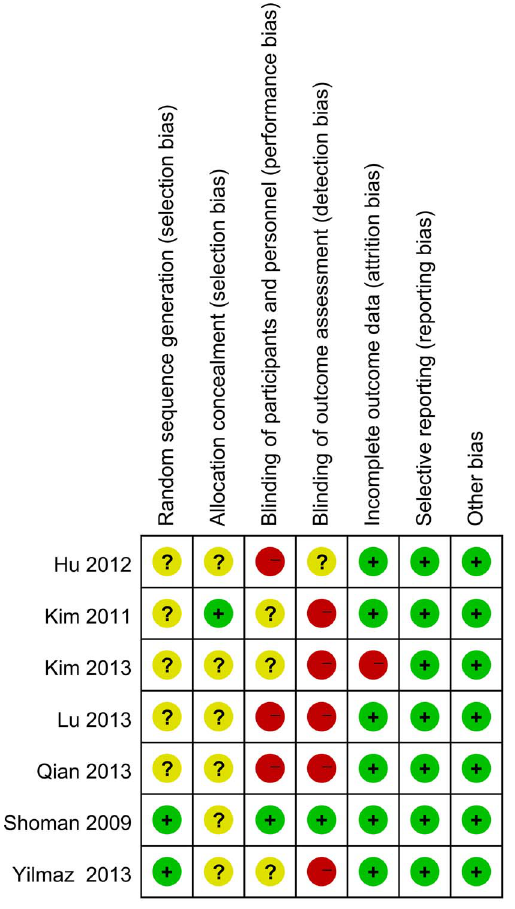
Figure 2. Risk of bias summary of included studies summary.